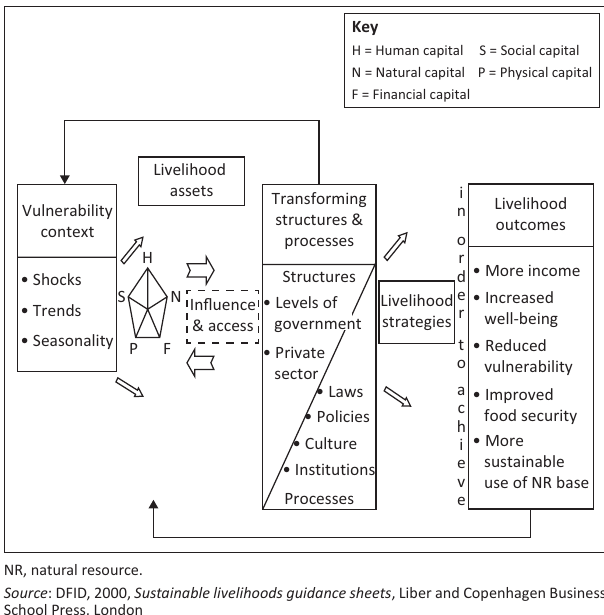
FIGURE 2: Sustainable livelihoods